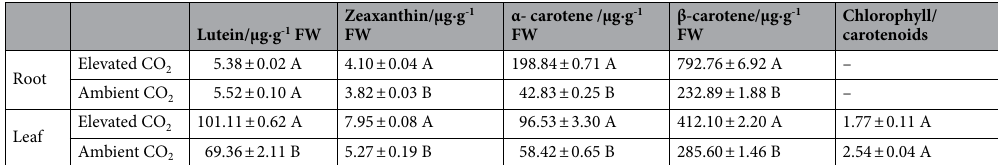
Table 1. Effect of CO 2 enrichment on carotenoids in carrot leaf and root. Sample were collected on 61 days after the initiation of the CO 2 treatment.